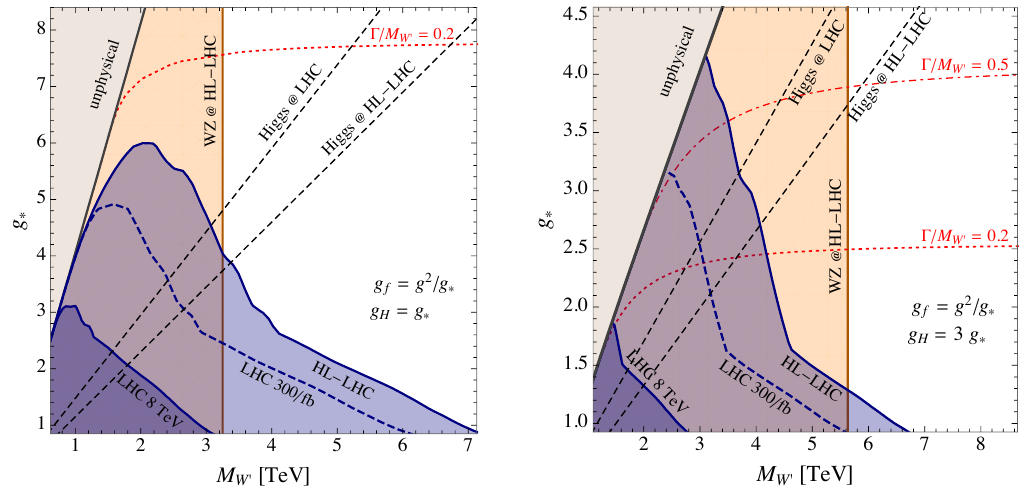
Figure 8 . Bounds on the mass and coupling of a heavy triplet resonance (see